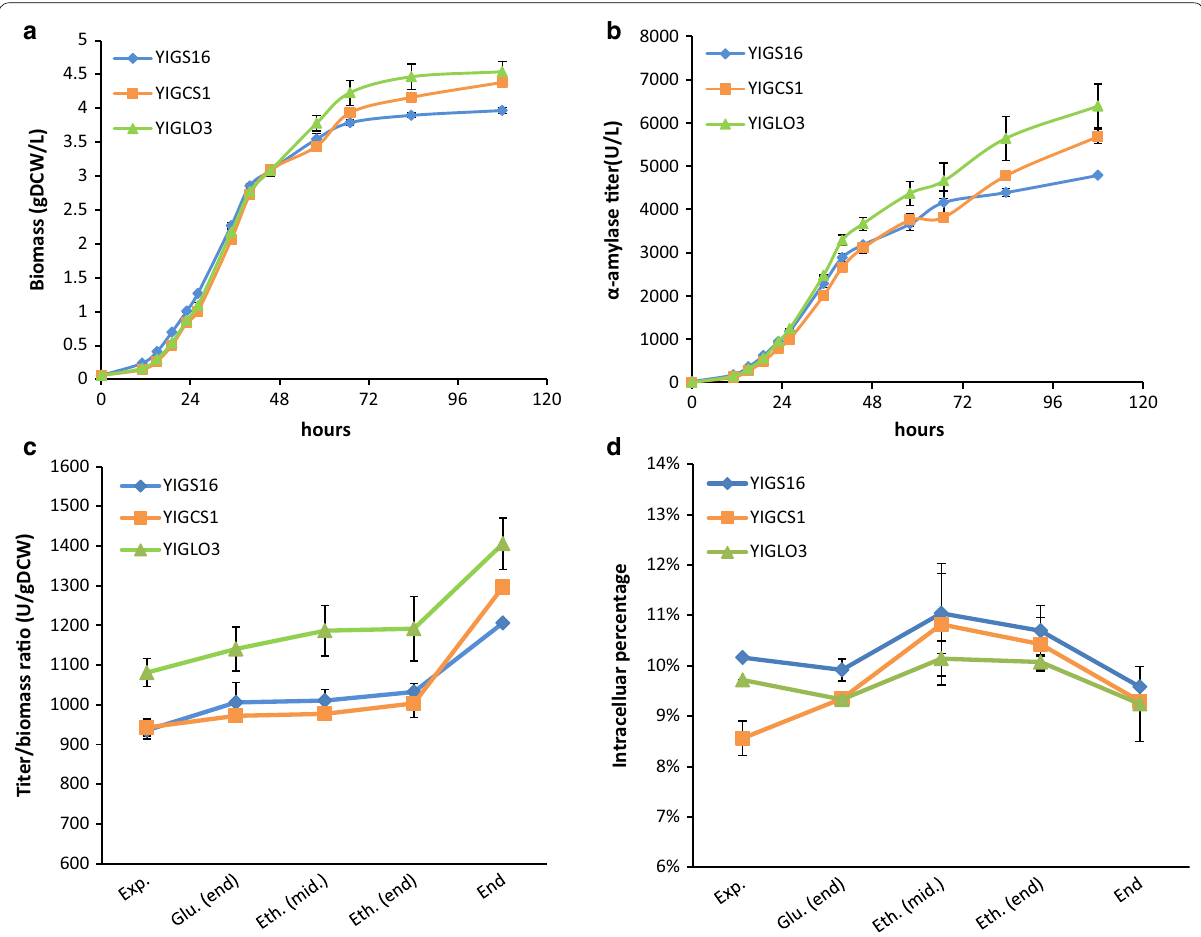
Fig. 3 Batch fermentation of the strain YIGS16, YIGCS1 and YIGLO3. The time course of a the biomass and b the α-amylase titer. c The titer/biomass ratio and d the percentage of intracellular α-amylase of the three strains at five different time points. Measurements are reported as the average value standard deviation from independent triplicates ±